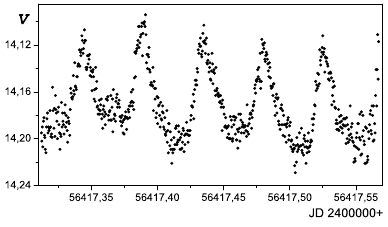
Figure 8: Ordinary superhumps on days 13-14 AM.